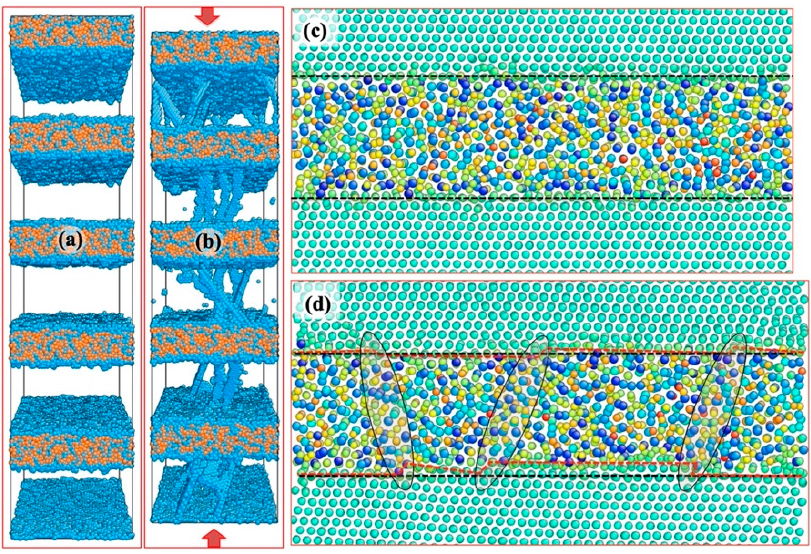
Figure 15. Molecular dynamics simulations of co-deformation in Cu/amorphous CuNb multilayers. ( a , b ) The deformed multilayers containing glide dislocations in Cu layers under uniaxial compression. The atomic structures around one amorphous CuNb layer before ( c ) and after ( d ) 8% of compressive strain. The curved CAIs are denoted by the red dotted lines, and local shears of atomic clusters are highlighted by three ellipses [74].